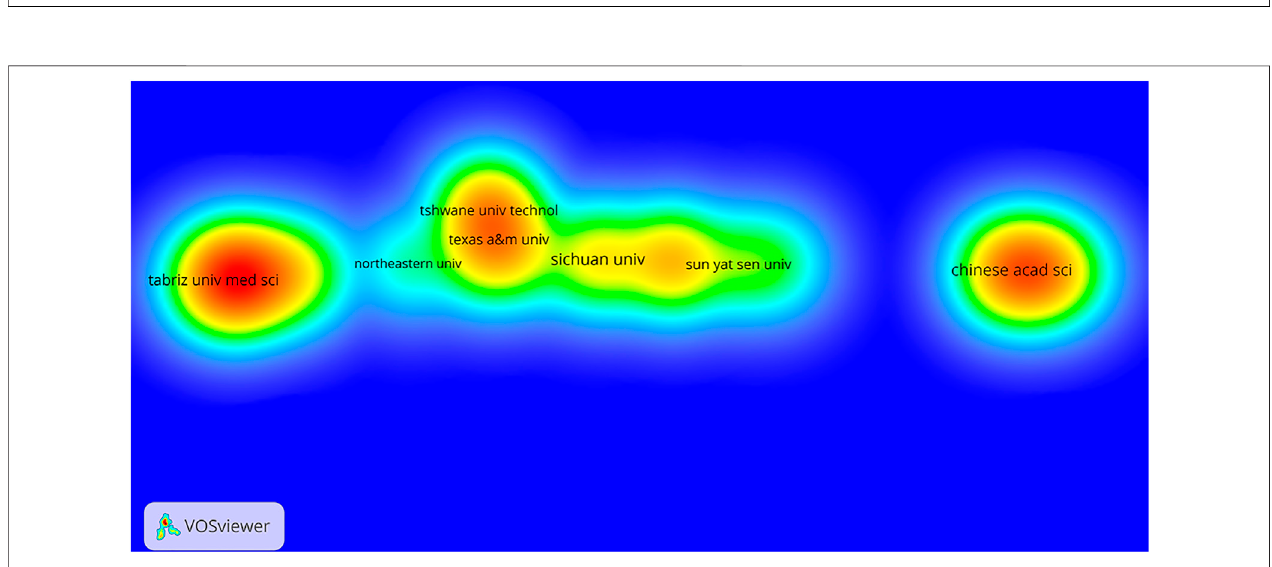
FIGURE3| Visualized mapofquantity ofpublicationbasedonnanocompositehydrogelandrelated researchissuedbyorganizationsandthedensity ofco-author relationship.